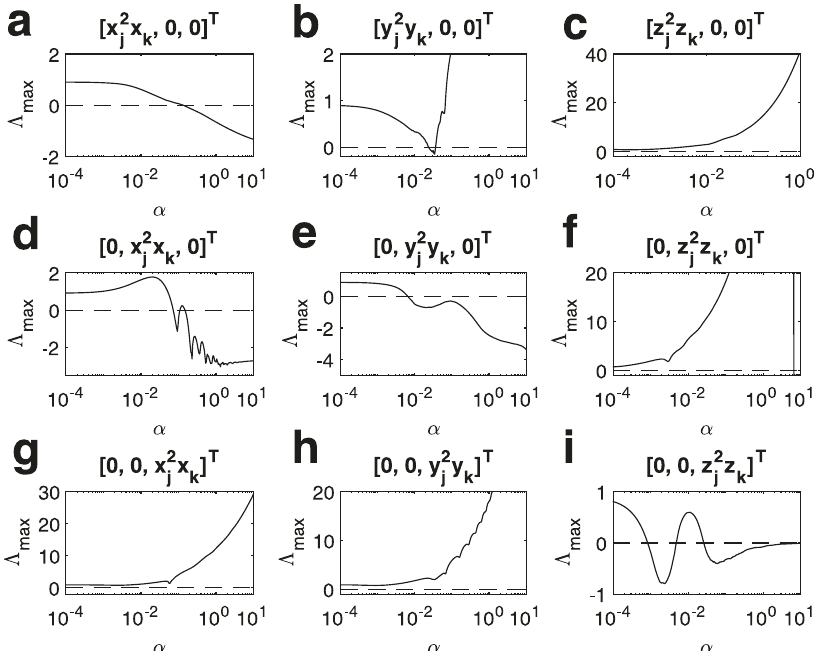
Fig. 5 Synchronization in simplicial complexes of Lorenz systems, in the case of natural coupling. The Master Stability Function is here calculated taking into account several coupling functions. a h ð 1 Þ ð x j Þ ¼ ½ x 3 j ; 0 ; 0 (cid:3) T and h ð 2 Þ ð x j ; x k Þ ¼ ½ x 2 j x k ; 0 ; 0 (cid:3) T , b h ð 1 Þ ð x j Þ ¼ ½ y 3 j ; 0 ; 0 (cid:3) T and h ð 2 Þ ð x j ; x k Þ ¼ ½ y 2 j y k ; 0 ; 0 (cid:3) T , c h ð 1 Þ ð x j Þ ¼ ½ z 3 ; 0 ; 0 (cid:3) T and h ð 2 Þ ð x j ½ 0 ; z 3 ; 0 (cid:3) T and h ð 2 Þ ð x j